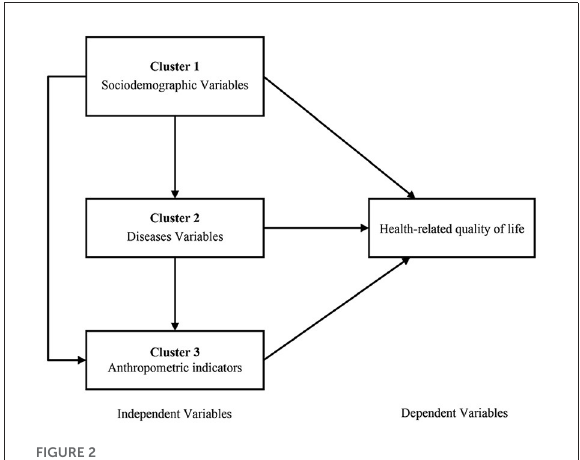
FIGURE2 The clustered multiple linear regression model and multidirectional associations (the direction of the impact is indicated by the direction of the arrows).